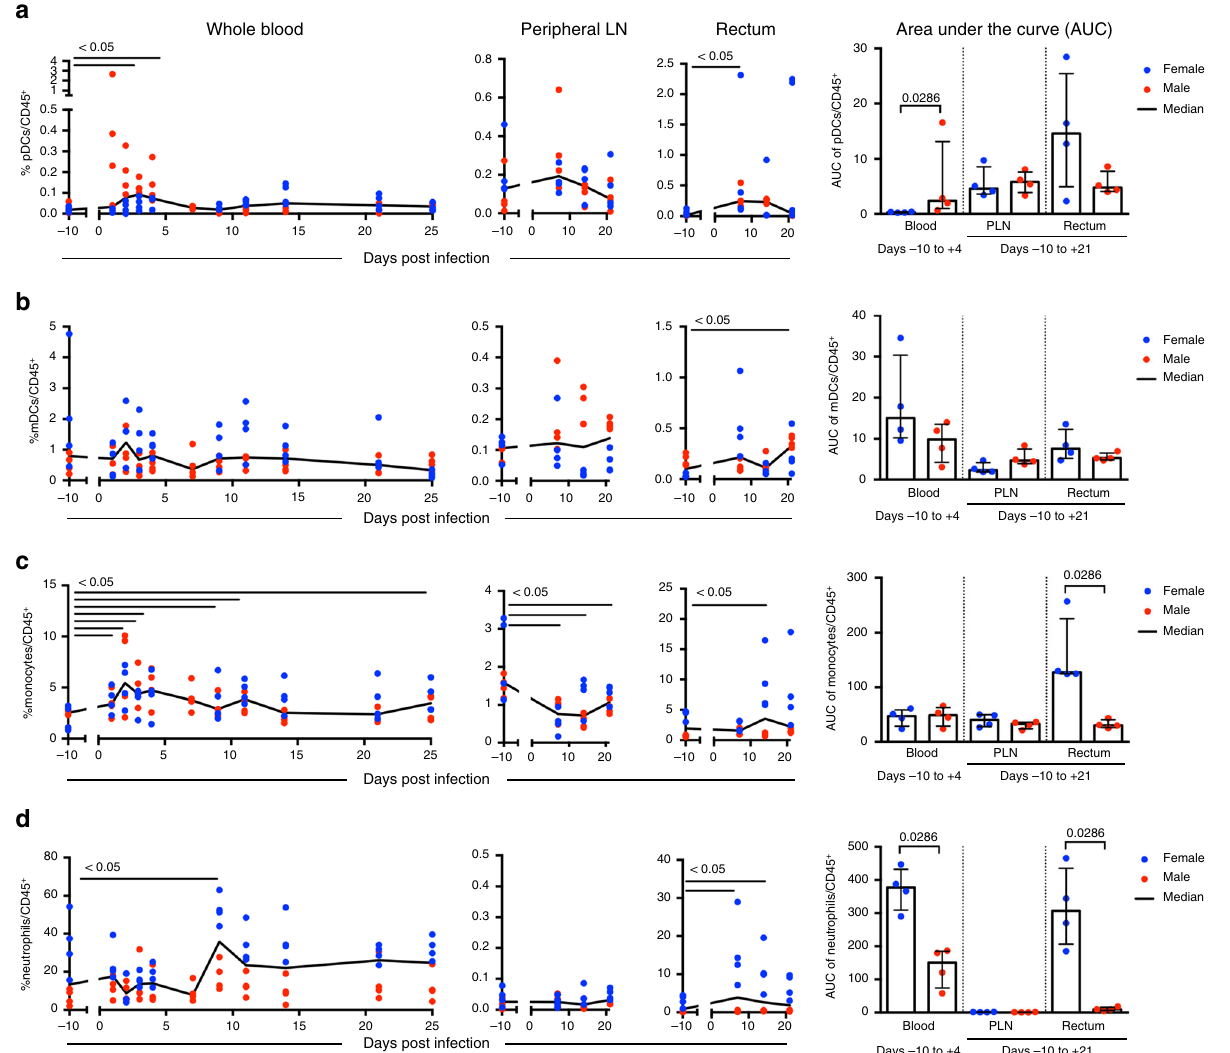
Fig. 2 Innate immune cells are rapidly recruited in response to ZIKV infection. Frequencies within CD45 + leukocytes and area under the curve (AUC) analysis of a pDCs (CD20 − CD3 − HLA − DR + CD14 − CD123 + CD11c − ), b mDCs (CD20 − CD3 − HLA − DR + CD14 − CD123 − CD11c + ), c monocytes (CD20 − CD3 − HLA − DR + CD16 ± CD14 ± ), and d neutrophils (CD3 − CD11b + CD14 + HLA-DR − SSC-A Hi ) in whole blood, peripheral lymph node (PLN), and rectum throughout the course of ZIKV infection were measured by fl ow cytometry. The frequency of these responses and AUC analysis in blood (AUC, days − 10 to + 4) and tissues (AUC, days − 10 to + 21) are shown. a – d Blue (females) and red (males) symbols in graphs represent individual animals, with curves indicating the median response for all animals over time. Comparisons of responses at each timepoint versus baseline were conducted by paired Wilcoxon test. Unadjusted p -values ≤ 0.05 are displayed, all p -values are available in Supplementary Table 2. a – d Differences in AUC between males and females were also determined using the Wilcoxon test, with signi fi cant unadjusted p -values ( p ≤ 0.05) shown. Dots represent individual animals (total n = 8), female (blue) and male (red), with bars indicating median with interquartile